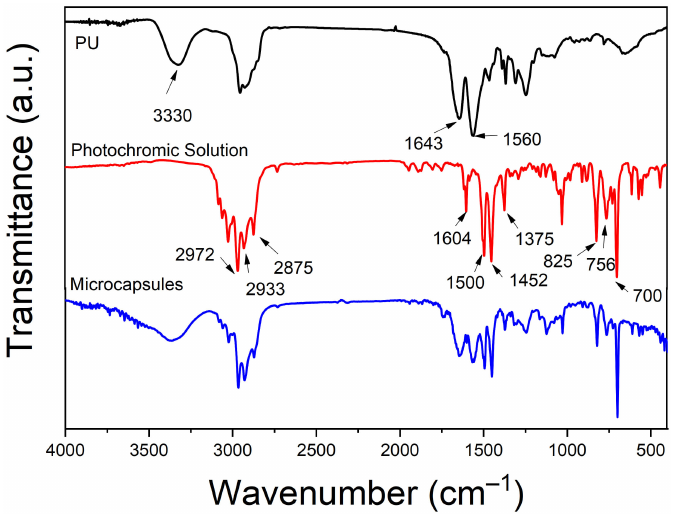
Figure 2. The infrared spectrum of NP solution, PU, and